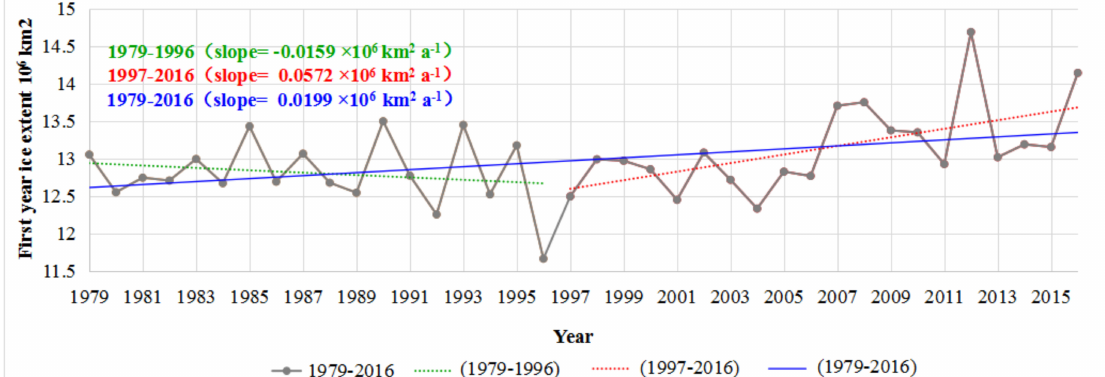
Figure 3. The variation of first year ice extent from 1979–2016. (Grey solid line: 1979–2016 yearly data; blue solid line: 1979–2016 trend; green dashed line: 1979–1996 trend; red dashed line: 1997–2016